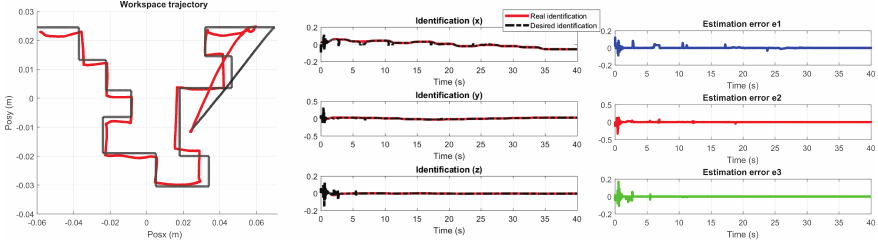
Figure 32. Performance PID wavenet-IIR controller for exercise 2, σ = r .